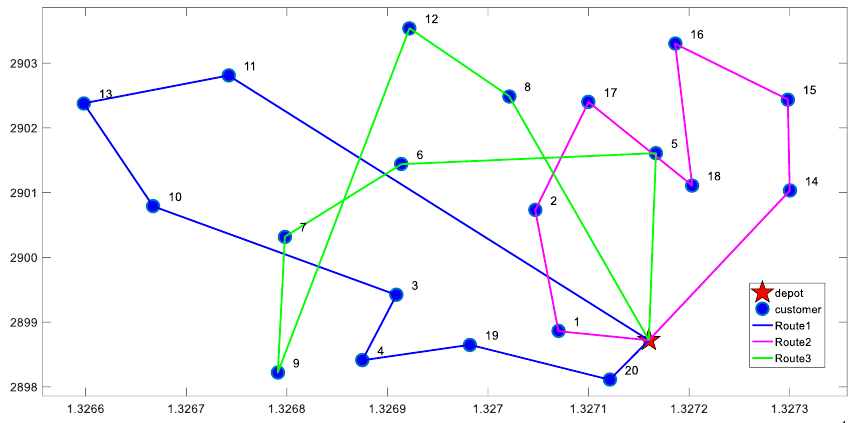
Figure 2. The optimal distribution paths of minimizing total cost.